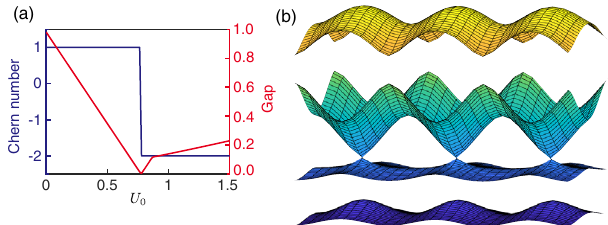
FIG. 2. Landau levels in the presence of a superlattice potential Eq. (8). We consider ϕ ¼ 2 = 3 , V 1 ¼ V 2 ¼ 1 , V 3 ¼ V 4 ¼ 1 . 4 . The superlattice is projected into the N ¼ 1 and N ¼ 2 Landau levels with spacing Δ E 12 ¼ 1 . Each Landau level splits into two subbands, so that, at n ¼ 2 = 3 , the two lowest subbands are filled. (a) Chern number and gap versus potential strength U 0 at n ¼ 2 = 3 . (b) The band structure at the transition ( U shows three emergent Dirac cones which mediate the transition between the C ¼ 1 and C ¼ − 2